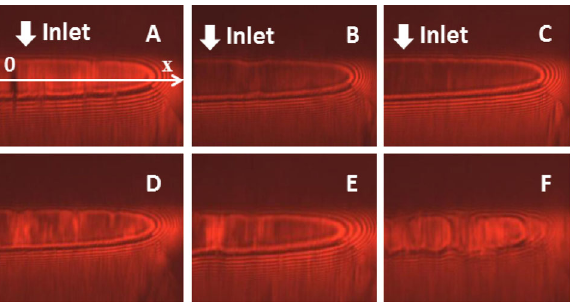
Fig. 11 Interference images for aluminum-complex-based grease and lithium-based grease with different thickener concentrations ( u = 15 mm/s, p max =0.58 GPa, straight line